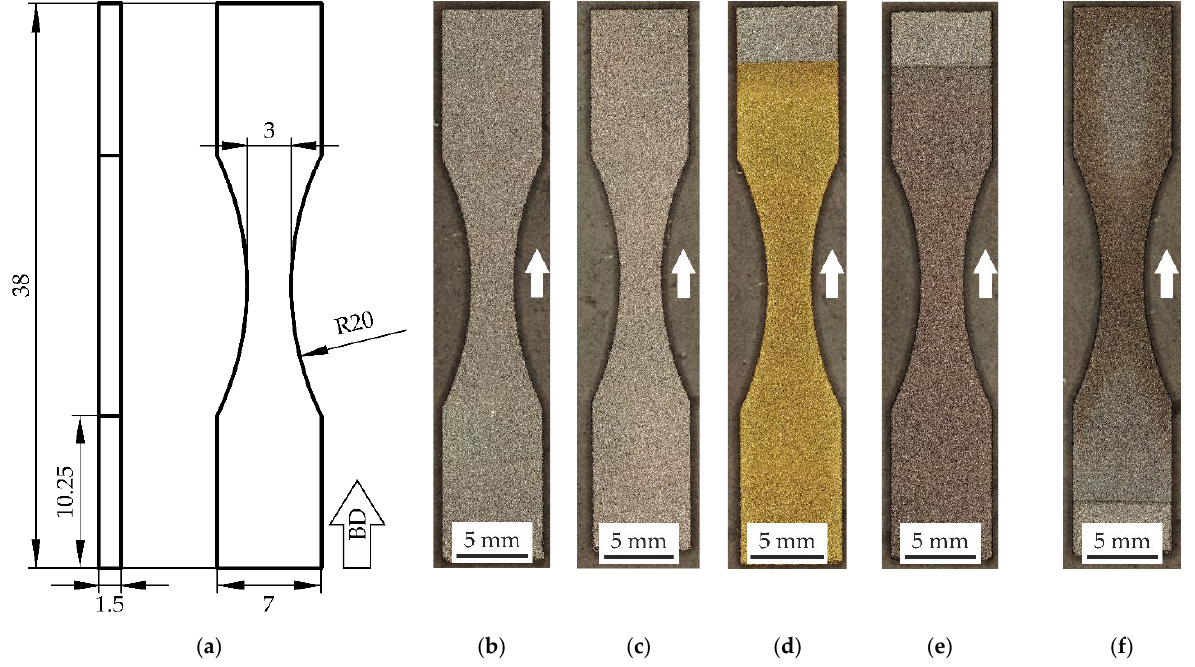
Figure 1. ( a ) Geometry and build direction (BD) of the fatigue specimens; overview of specimens in different conditions ( b ) as built; ( c ) stress relieved (SR); ( d ) titanium nitride (TiN); ( e ) titanium carbonitride (TiCN); ( f ) silver-containing amorphous carbon (a-C:Ag). The surface roughness of the specimens was measured using the tactile profile